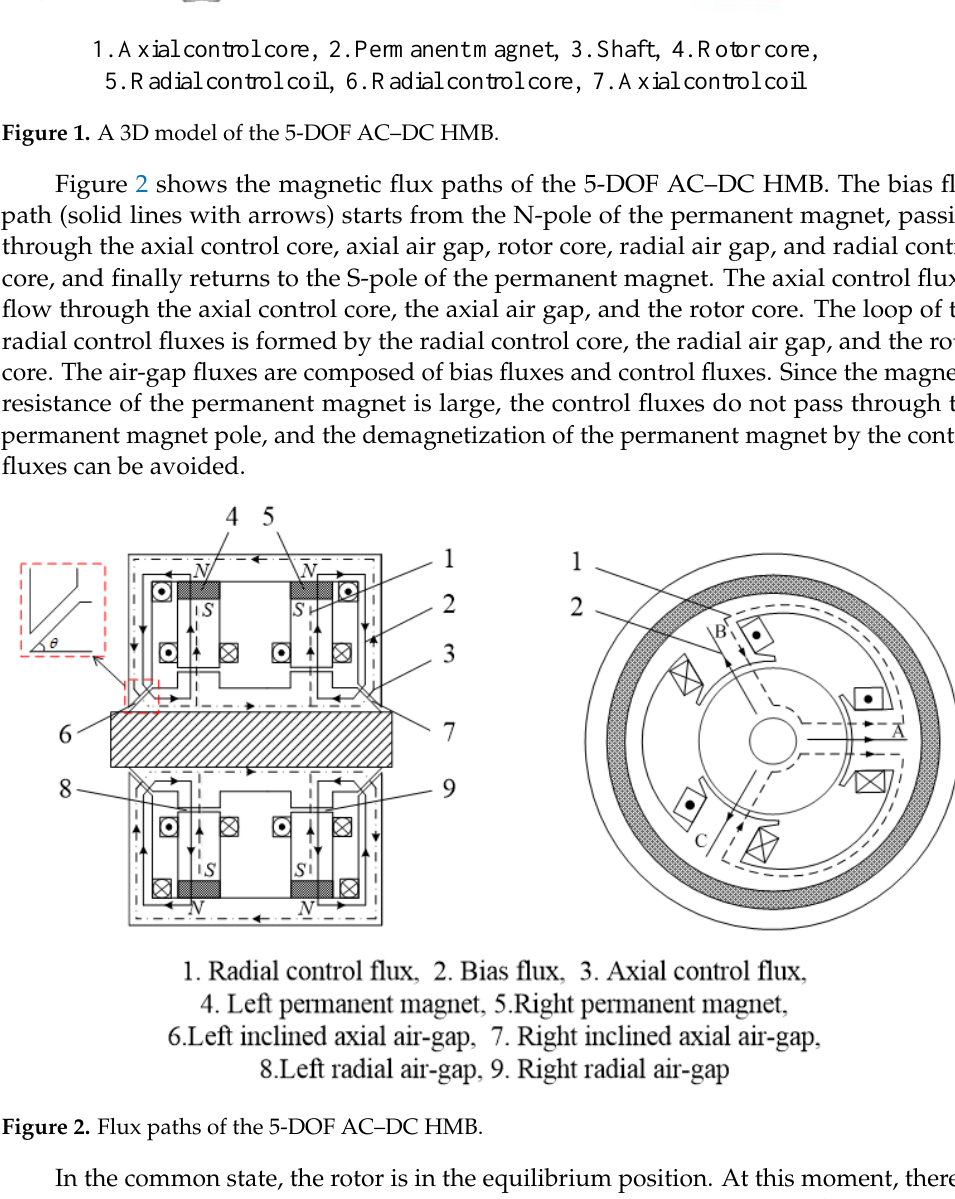
Figure 2. Flux paths of the 5-DOF AC–DC HMB.